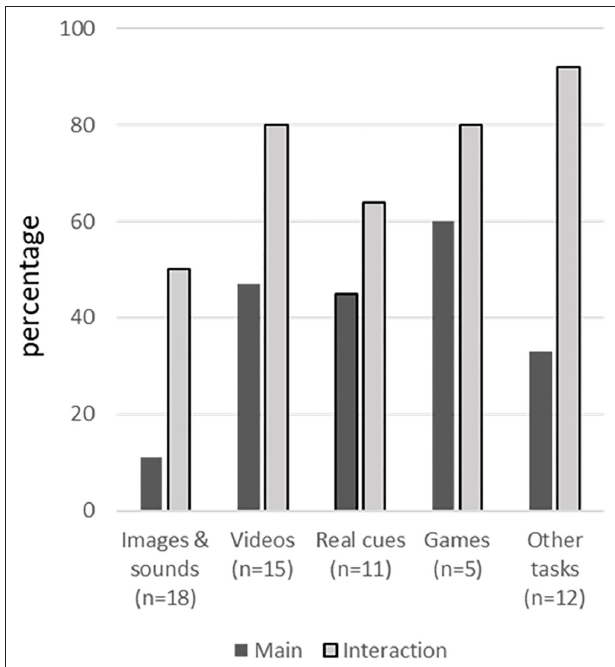
FIGURE 2 | Percentage of studies showing a significant effect of stimuli alone and in interaction with other conditions or participant subgroups, separately for each stimulus